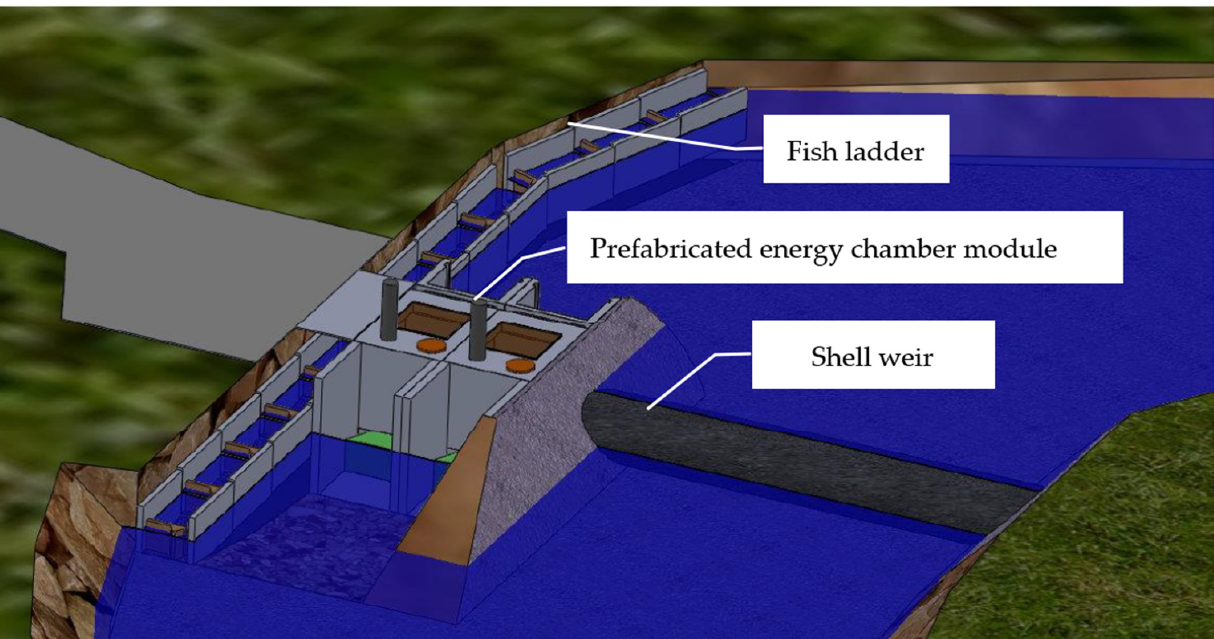
Figure 1. Modular small hydropower plant concept.